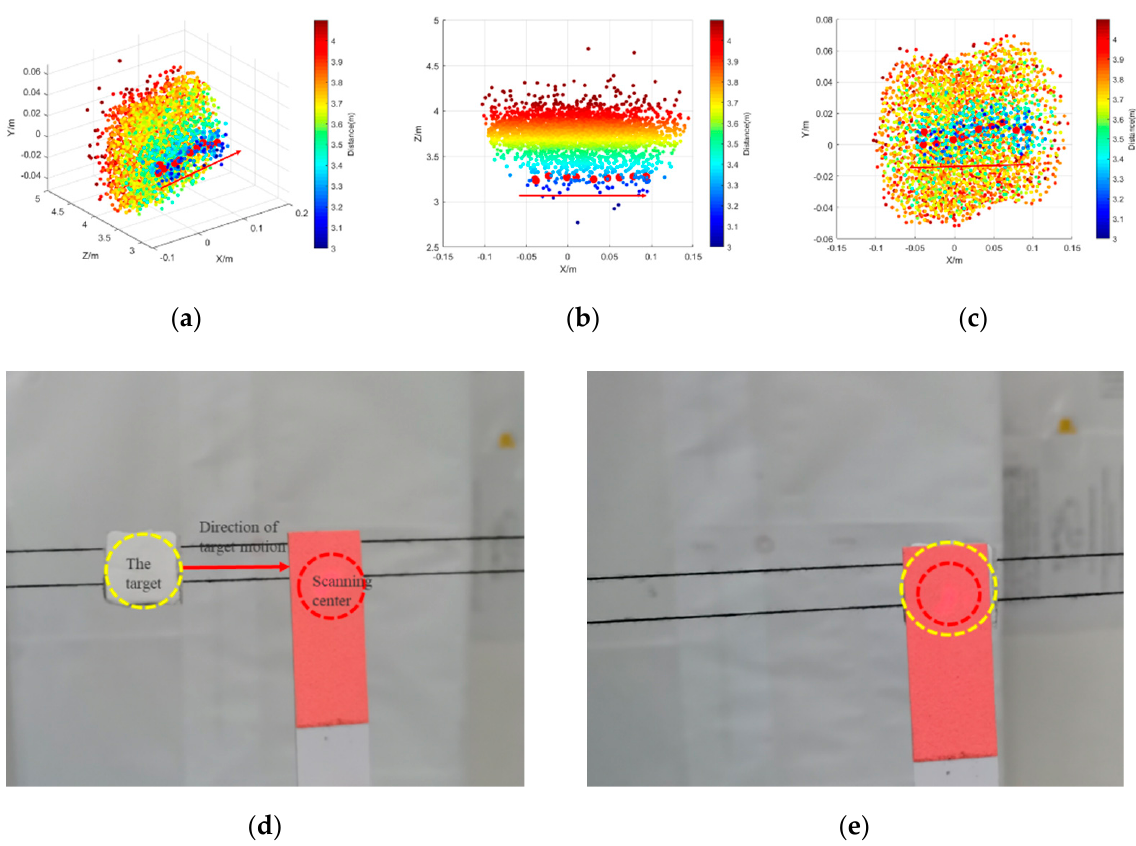
Figure 9. Target and background 3D information and image: ( a – c ) 3D point clouds and its top view and front view during tracking the target, ( d ) the image before tracking the target, and ( e ) the image after tracking the target.